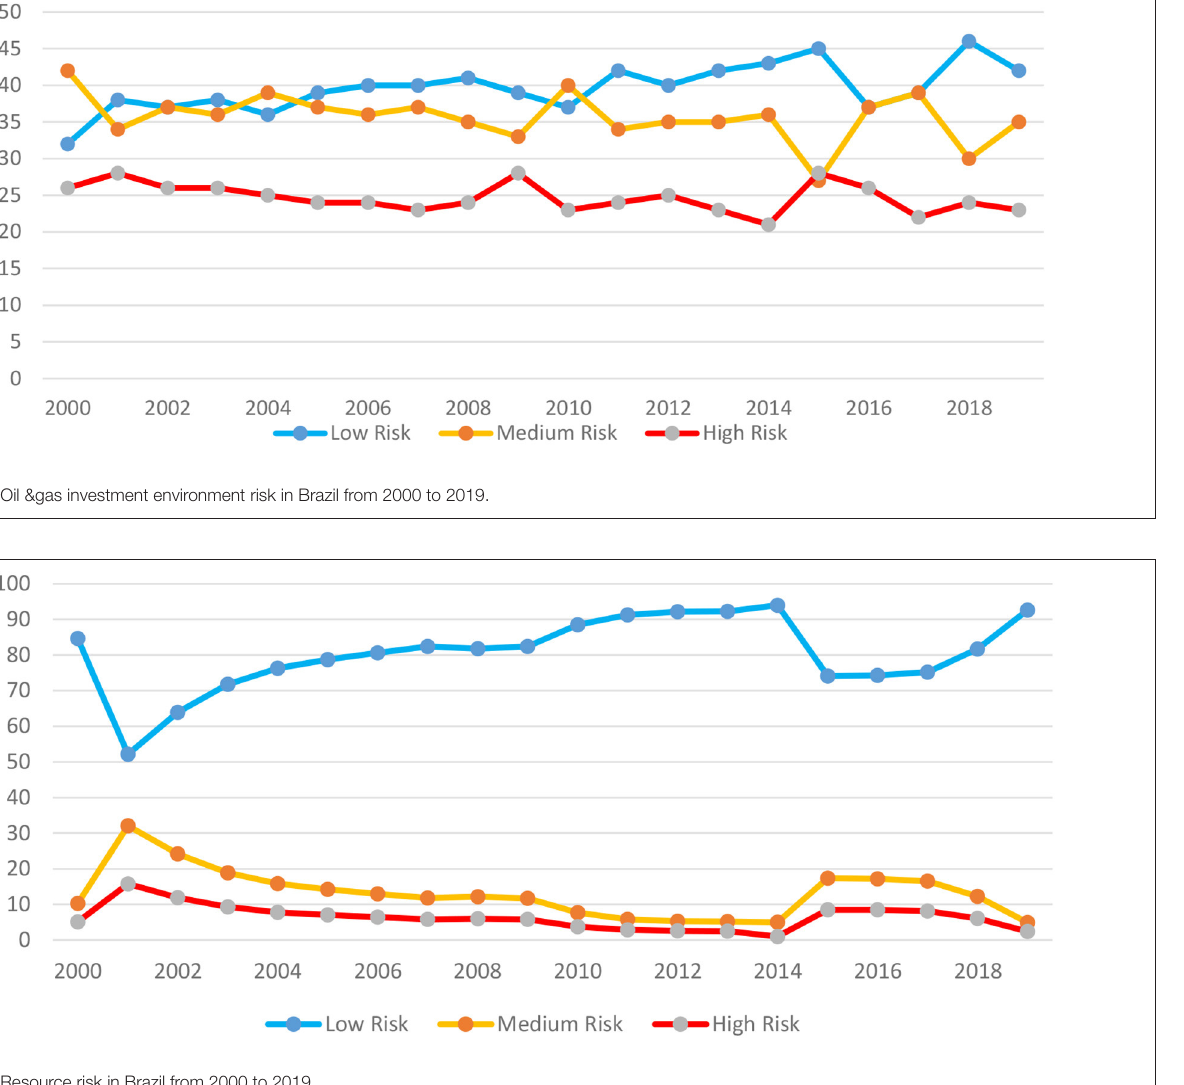
FIGURE 6 | Resource risk in Brazil from 2000 to